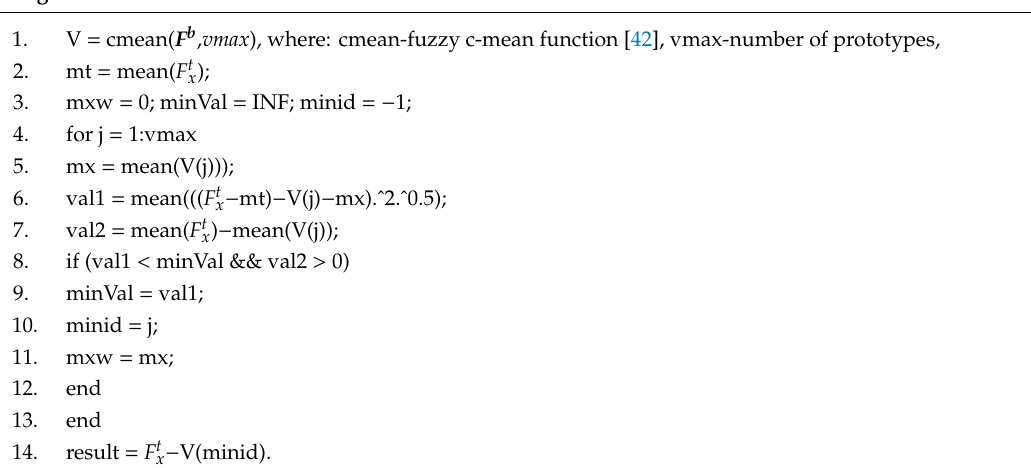
Algorithm 1 generates a set of characteristic backgrounds denoted as V based on